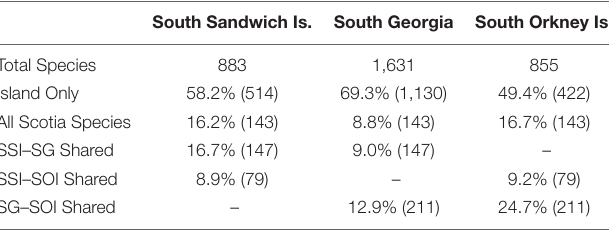
TABLE 4 | Faunal similarity between South Georgia (SG), South Orkney Islands (SOI) and the South Sandwich Islands (SSI). South Sandwich Is. South Georgia South Orkney Is.